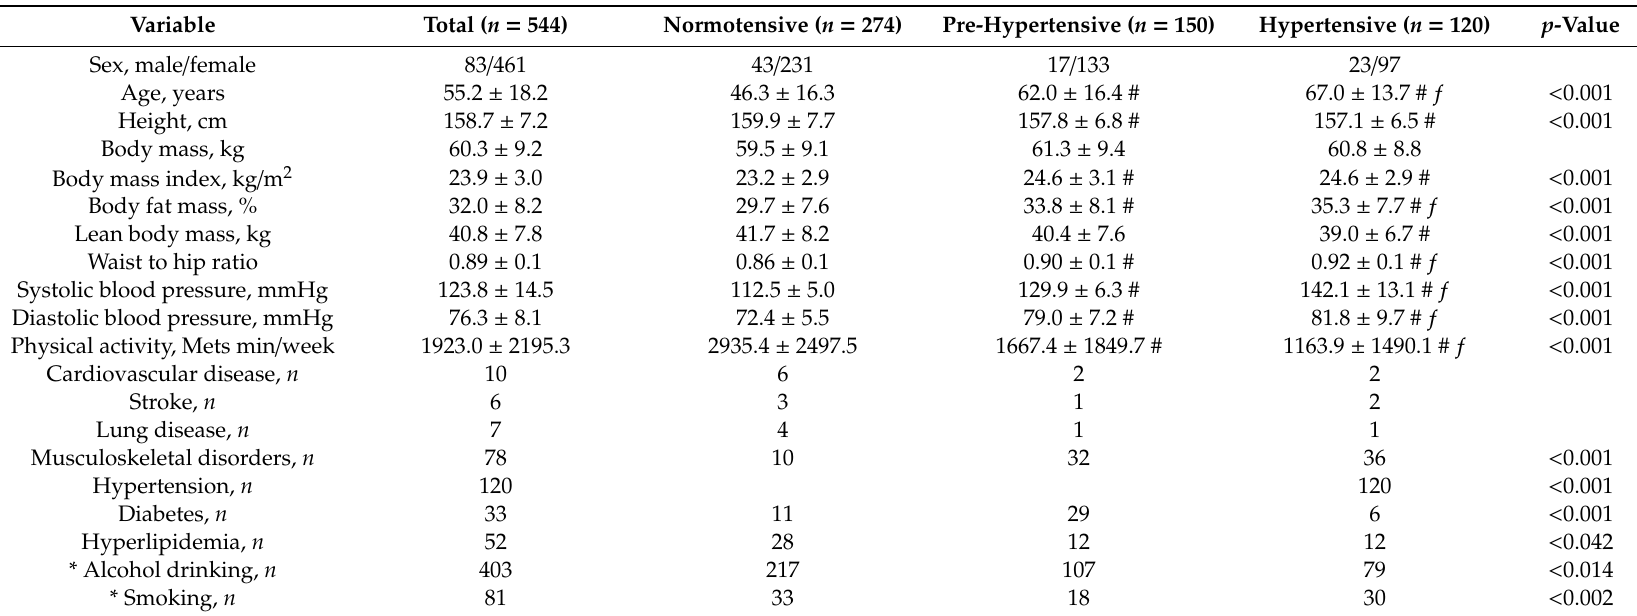
Table 1. Di ff erences in general characteristic among groups according to the blood pressure